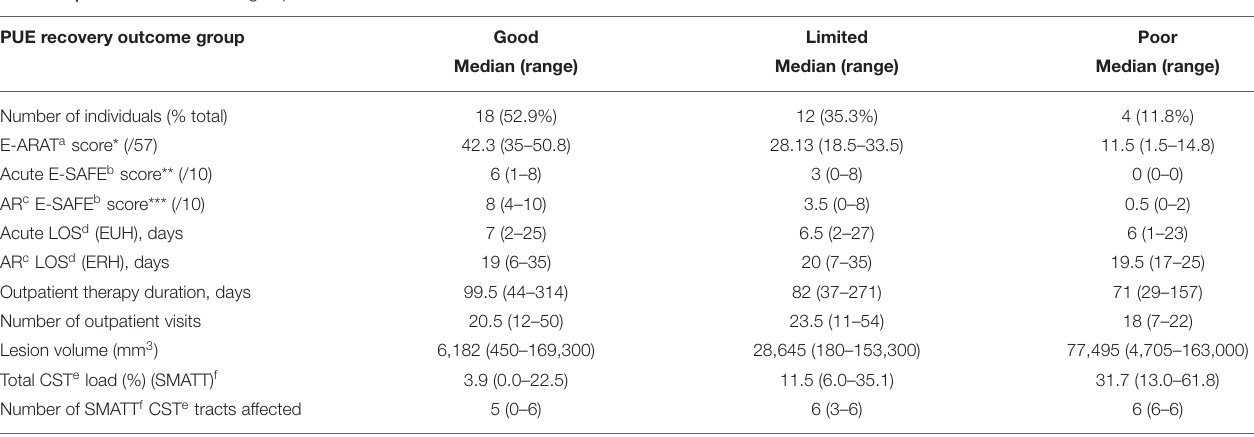
TABLE 1 | PUE outcome cluster group